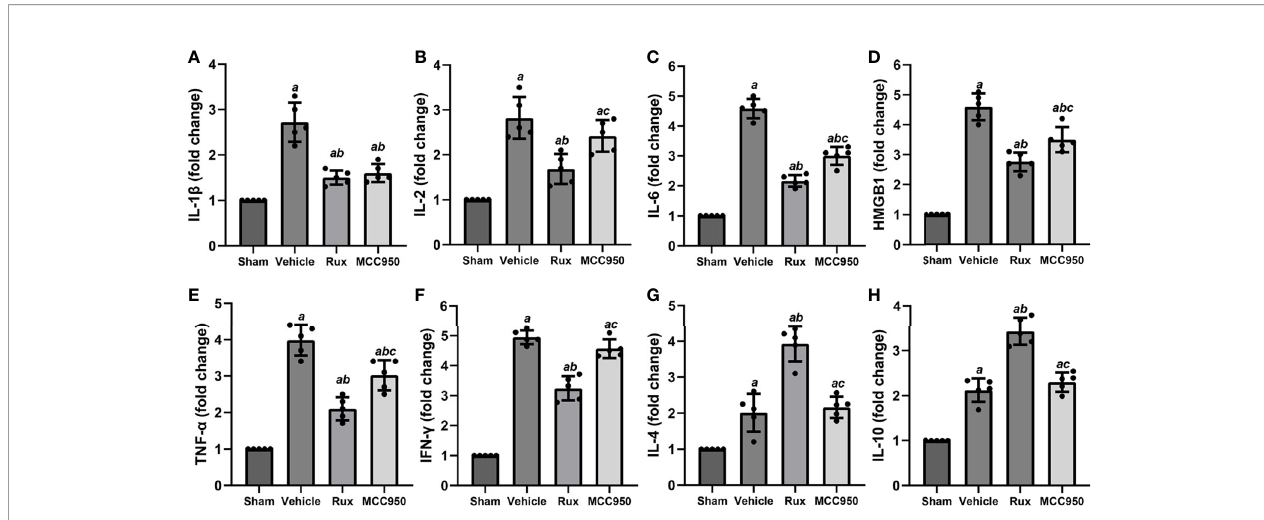
FIGURE 7 | Rux treatment reduced the mRNA expression of proin fl ammatory cytokines 3 days after MCAO. (A – F) mRNA expression of IL-1 b , IL-2, IL-6, HMGB1, TNF- a , and IFN- g . (G, H) mRNA expression of IL-4 and IL-10. The data are shown as fold changes compared to the sham. n = 5. a P < 0.001 versus sham; b P < 0.01 versus vehicle; c P < 0.05 versus Rux.